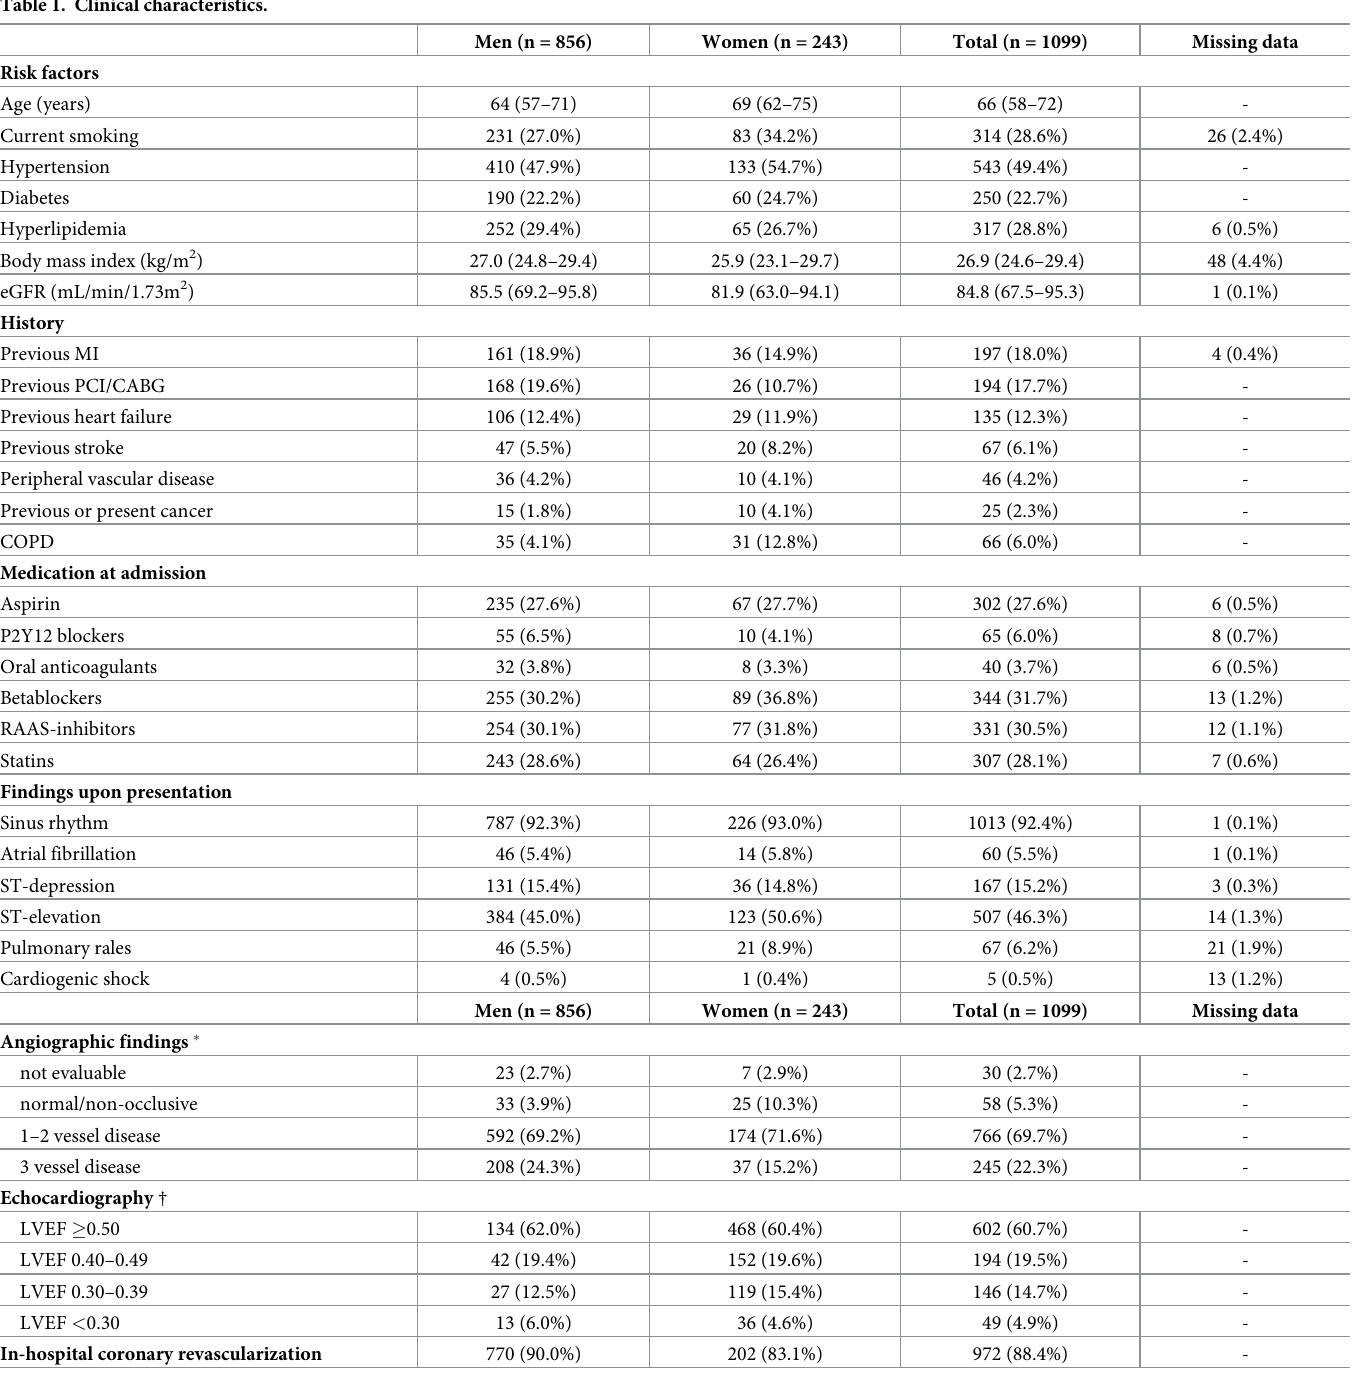
Table 1. Clinical